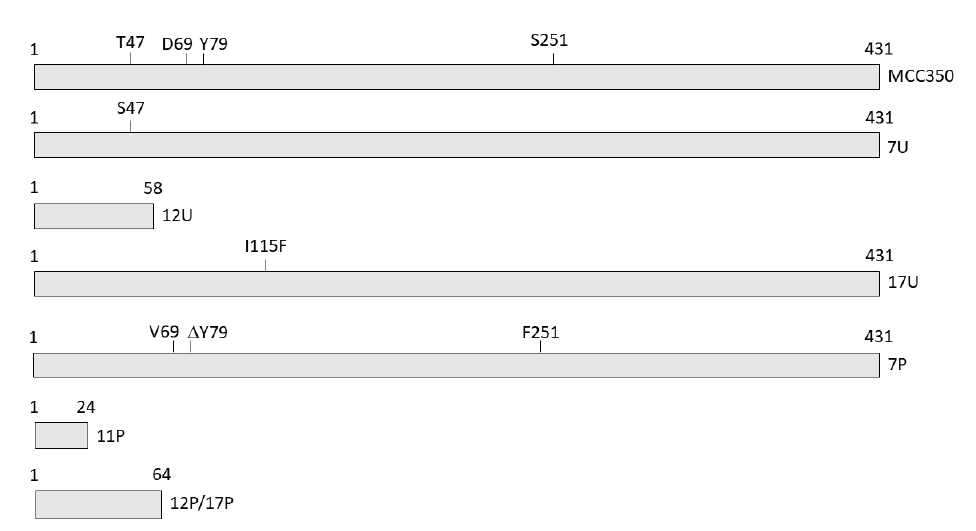
Figure 8. Schematic representation of the VP1 mutants detected in urine and serum from HIV1+ patients. VP1 of the prototype MCC350 is depicted on the top. Amino acid substitutions, deletion and truncated VP1 are shown. Table 2. Replication efficiency in A549 as determined by qPCR.